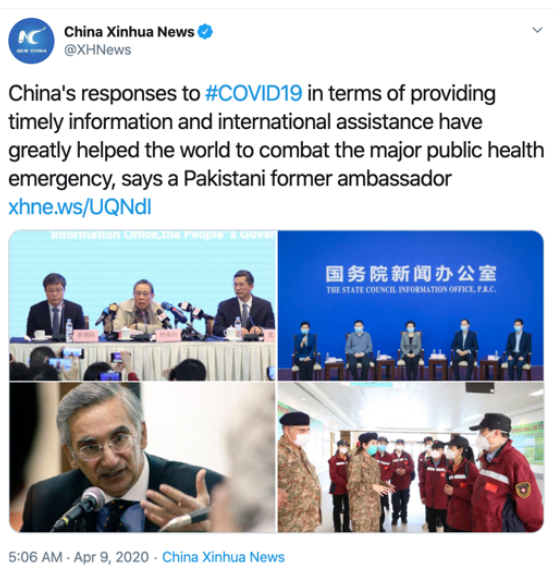
Figure 1. Screenshot of @XHNews’ tweet (captured on 10 April 2020, same with the following screenshots). Source: China Xinhua News (2020).